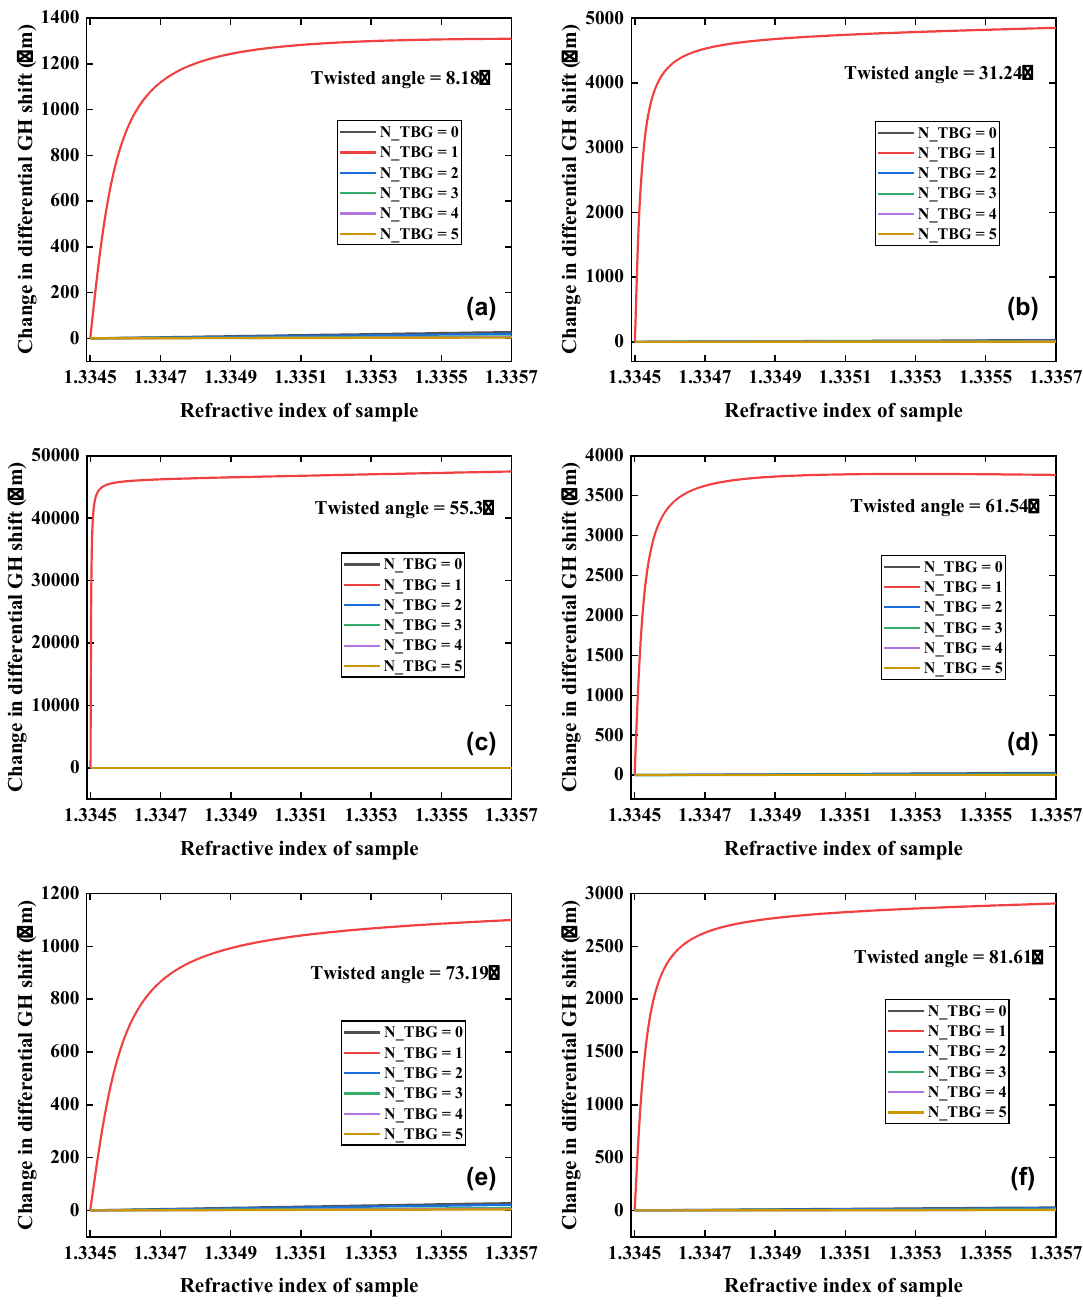
Figure 5: Change in differential GH shift versus RI variation in sensing interface of Au film-TBG configuration by tuning the number (0–5) of TBG system and twisted angles: (a) 8.18 ◦ , (b) 31.24 ◦ , (c) 55.3 ◦ , (d) 61.54 ◦ , (e) 73.19 ◦ , and (f) 81.61 ◦ . Noting that, the thickness of Au film is 44 nm, and the excitation wavelength is 632.8 nm. N_TBG stands for the number of TBG layer. The running buffers were HEPES, and PBS